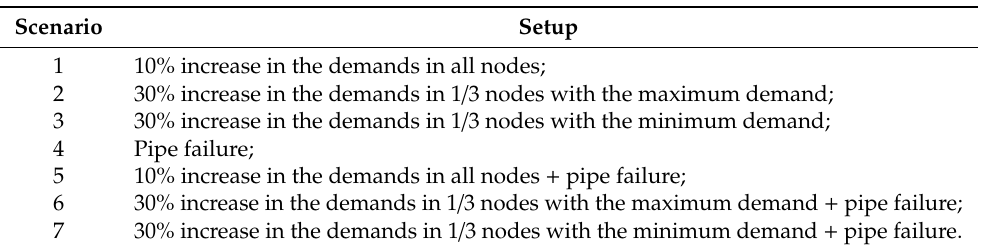
Table 7. Details of operation scenarios.